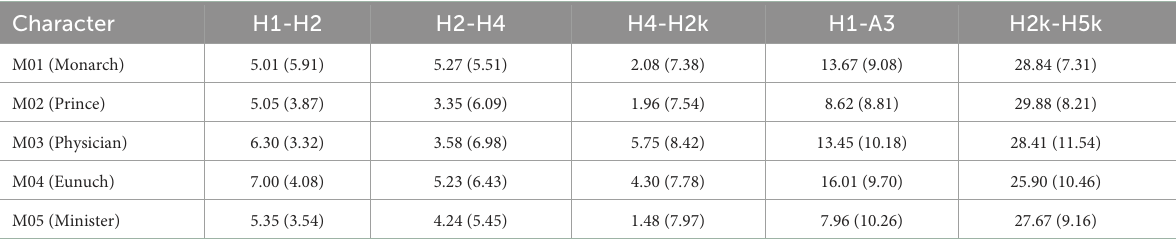
TABLE 3 Harmonic measures of the five characters (mean ± S.D., in dB, two decimal places).